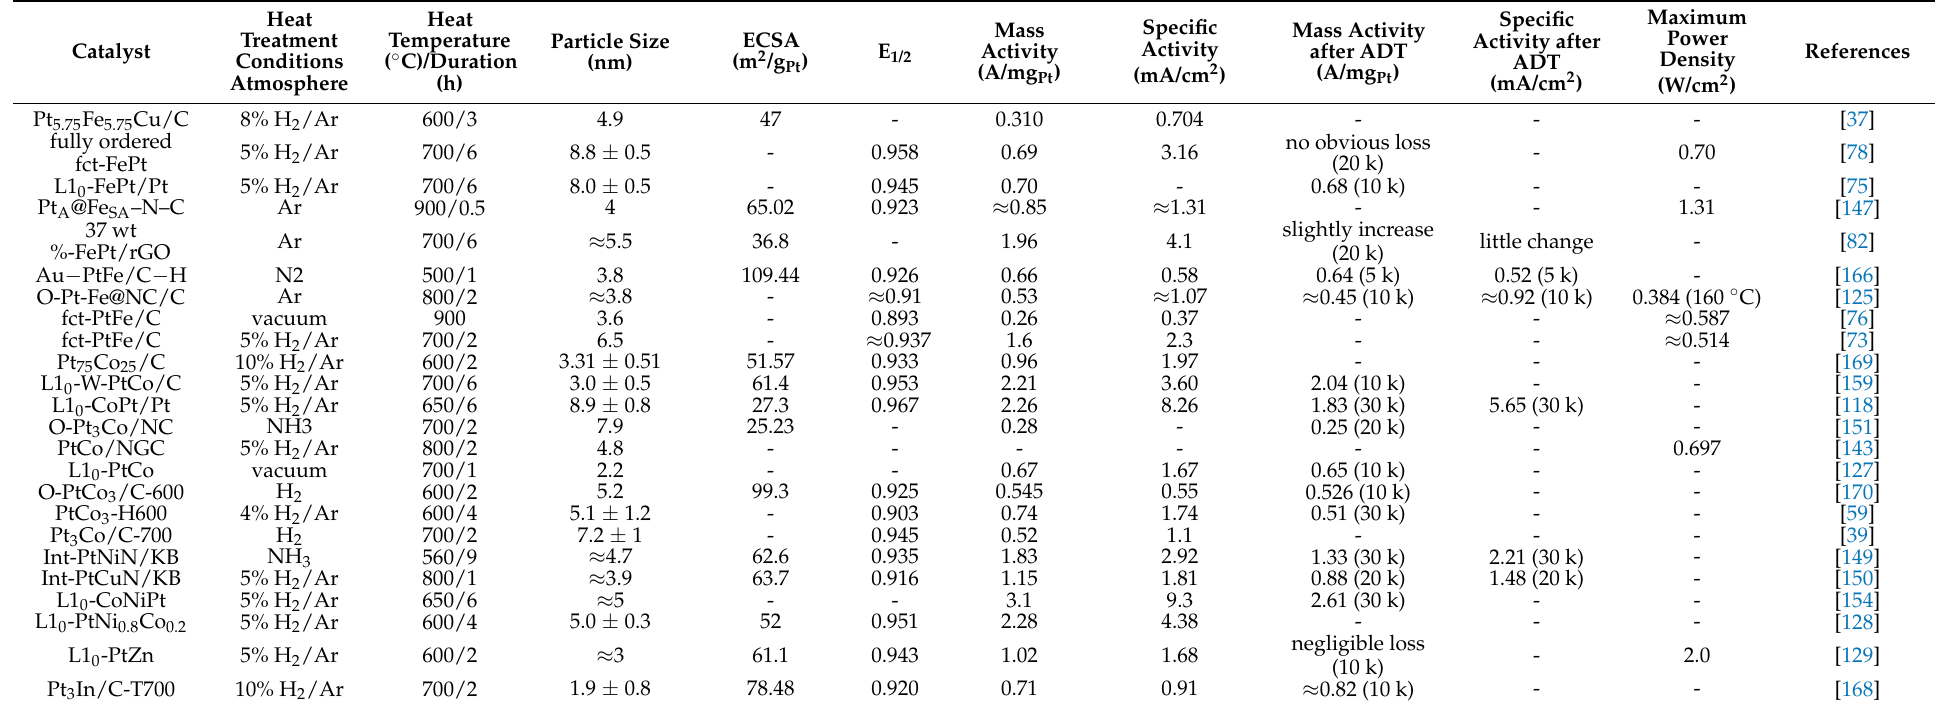
Table 1. Catalytic properties of Pt-based intermetallic nanocrystals in oxygen reduction